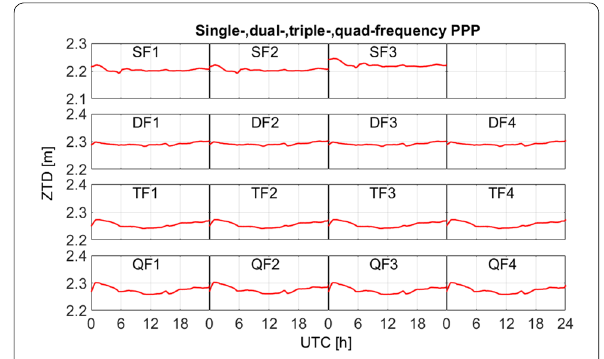
Fig. 5 ADEV of the BDS single-, dual-, triple- and quad-frequency PPP time transfer using the time-link BRCH–XIA3 on DOY 17, 2019